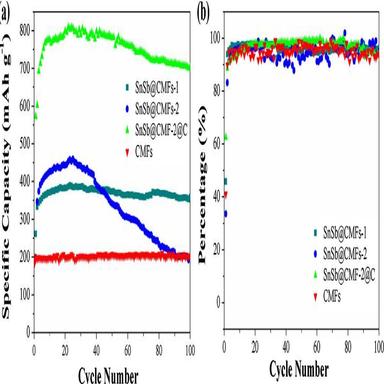
Cycling performance (a) and corresponding Coulombic efficiencies (b) of SnSb@CMFs-1, SnSb@CMFs-2, SnSb@CMF-2@C, and CMFs at a current density of 100 mA∙g1 .